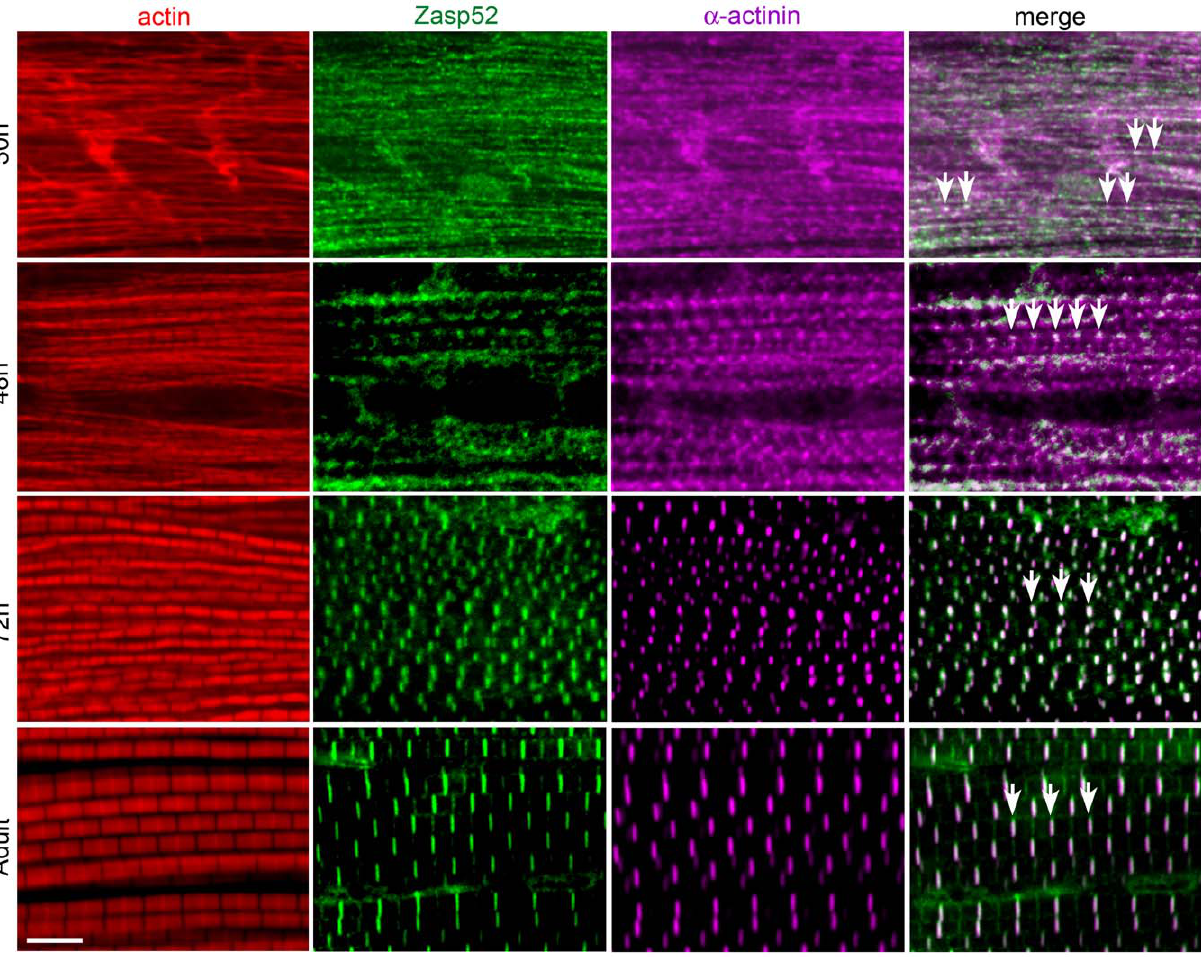
Figure 2. Zasp52 is an early Z-disc marker in IFM. Antibody staining of IFM at different stages of pupal development at 25 u C, stained with phalloidin (red), anti-Zasp52 (green), and anti- a -actinin (magenta) antibody. At 30 h APF, Zasp52 and a -actinin have a punctate distribution along the forming myofibrils. Arrows indicate co-localization. At 48 h APF, Zasp52 and a -actinin appear as broad dots at the forming Z-disc. At 72 h APF, Zasp52 and a -actinin label in evenly spaced stripes at the Z-disc. In the adult, myofibrils have grown in width and Zasp52 and a -actinin are labeled in striations. Scale bar, 5 m m.